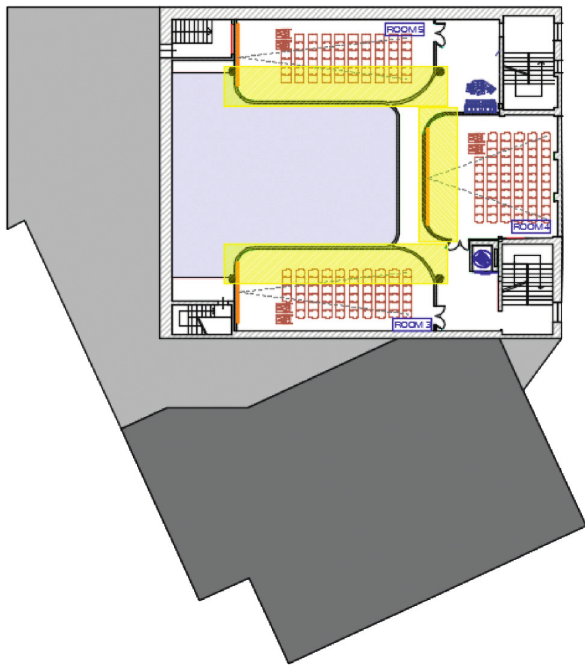
Figure 11: Second floor